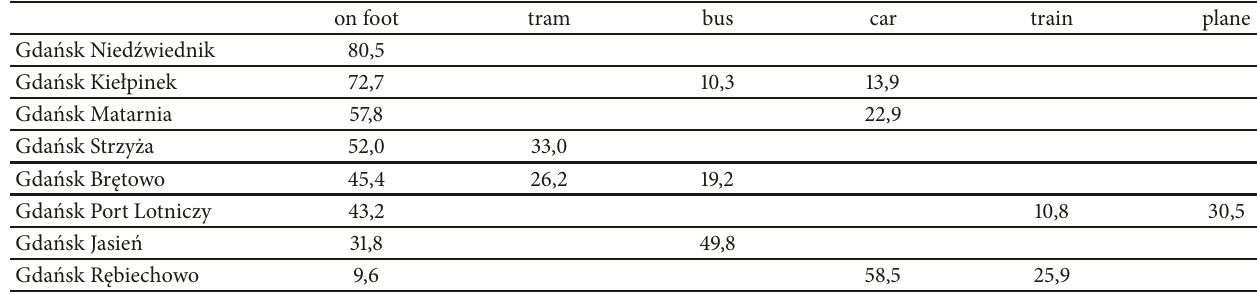
Table 2: Main (over 10% share) ways of reaching the PMR stations and continuing the journey, based on the results of a survey conducted between 17.10 and 16.11.2017. on foot tram bus car train